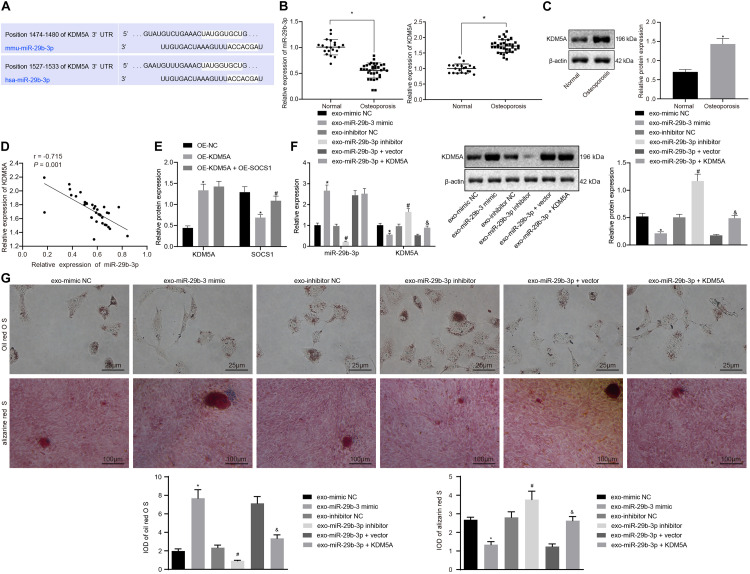
Extracellular vesicle (EV)-encapsulated miR-29b-3p-derived from bone marrow-derived mesenchymal stem cells (BMSCs) potentiated osteogenic differentiation by specifically inhibiting the expression of lysine demethylase 5A (KDM5A). (A) Bioinformatics prediction of the binding site of miR-29b-3p on KDM5A. (B,C) The expression of miR-29b-3p and KDM5A in the EVs of hBMSC isolated from osteoporotic patients or non-osteoporotic patients was detected by real-time quantitative polymerase chain reaction (RT-qPCR) (B) and western blot analysis (C). *p < 0.05 compared to non-osteoporotic patients. (D) Pearson correlation analysis of miR-29b-3p and KDM5A expression levels in osteoporotic patients. (E) The interaction of miR-29b-3p with KDM5A was detected by dual-luciferase reporter assays. *p < 0.05 compared to NC mimic + wild-type (WT) KDM5A 3′ untranslated region (3′-UTR). (F) The expression of miR-29b-3p and KDM5A after the overexpression or knockdown of miR-29b-3p was analyzed by RT-qPCR and western blot analysis. (G) Osteogenic differentiation was analyzed by Oil red O staining and alizarine red staining (undifferentiated cells were indicated by the red colored lipid droplets, 400×). *p < 0.05 compared to the EV-mimic NC group, #p < 0.05 compared to the EV inhibitor NC group, &p < 0.05 compared to the EV-miR-29b-3p + vector group. The results represent three independent experiments.